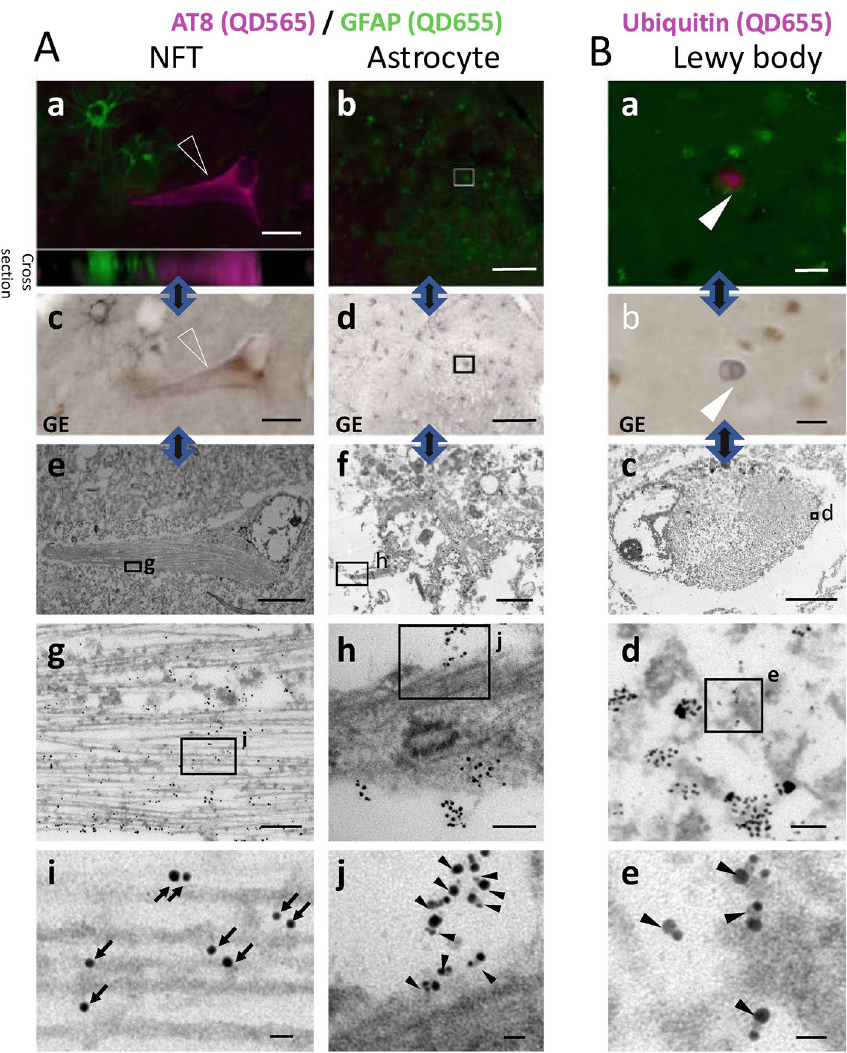
Figure 2. EM distinction of QD565 for AT8 and QD655 for GFAP after gold enhancement and their LM counterparts on double immunolabeled section. (A) A section from the autopsied brain was double immunolabeled for AT8/QD565 (magenta) and GFAP/QD655 (green). (a) Extended focus image (EFI) of an NFT (open triangle) and astrocytes and its cross-sectional reconstruction (20 μm thick). Fluorescent signals from QD565 and QD655 were similarly intense throughout the entire depth of the section. (b) EFI of astrocytes on the same section at different site. An astrocyte enclosed in the rectangle was targeted for subsequent EM observation. (c,d) Bright-field LM counterpart of targets in (a,b) after gold enhancement and post-fixation. QD565 and QD655 labeled structures are darkened. (e–j) EM images corresponding to the LM images, after gold enhancement of the section. The areas enclosed by rectangles correspond to the images just below. While the filaments in NFT (e,g,i) was labeled with high contrast spherical QD565 (arrow), the glial fibers of the astrocyte (f,h,j) was labeled with rod-like QD655, which showed high contrast nanospheres deposited at the tips of the low contrast QD655 nanorods (filled triangle). The QD565 (in i, arrow) and the QD655 label (in j, filled triangle) are readily distinguishable from each other by their characteristic shapes after gold enhancement. Bars in a: 20 μm, b: 100 μm, c: 20 μm, d: 100 μm, e: 10 μm, f: 2 μm, g: 200 nm, h: 100 nm, i and j: 20 nm. (B) Another section of the same autopsied brain was labeled with ubiquitin/QD655 (magenta). A fluorescence image of a Lewy body (a, open triangle) were directly compared with bright-field LM image (b) and EM image (c–e) after gold enhancement. Loose and short ubiquitin-positive fibers of a Lewy body was labeled by rod-like QD655 (e, filled triangle), which showed high contrast nanosphere deposits at the tips of the nanorods. Bars in a and b: 20 μm, c: 5 μm, d: 100 nm, e: 20